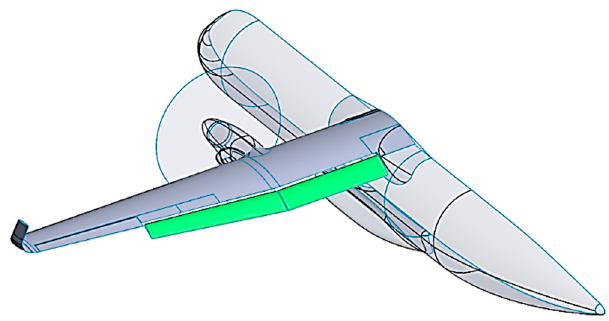
Figure 2. Reference turboprop aircraft for Clean Sky 2—Airgreen 2 morphing flap.